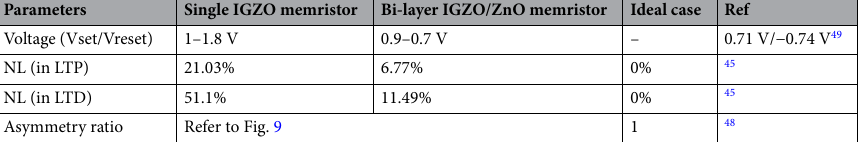
Table 1. Comprehensive summary table of DC and LTP/LTD characteristics in the single IGZO and bi-layer IGZO/ZnO memristors.